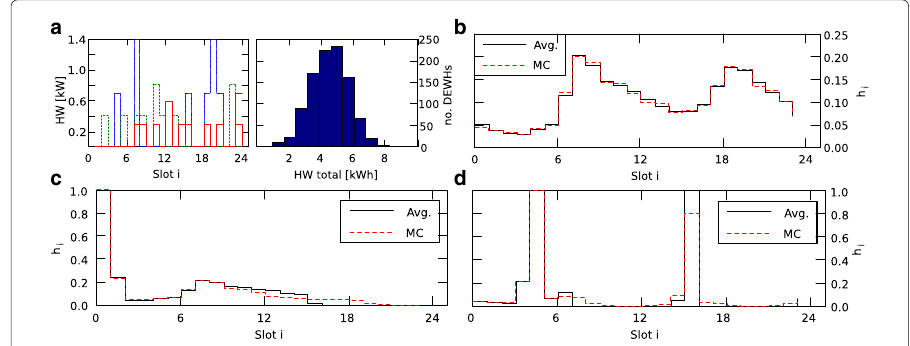
Fig. 6 Comparison of averaged optimization and Monte Carlo simulation. a MC HW profiles, b maintain minimum temperature, c heat to maximum, d heat to maximum